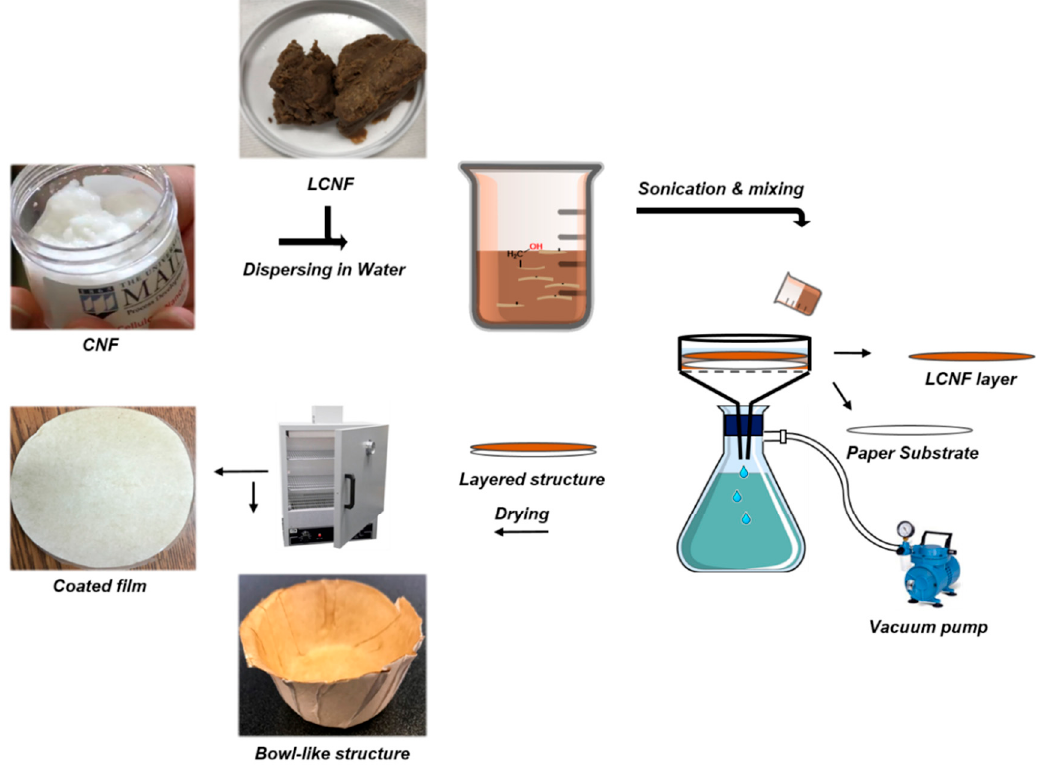
Figure 9. Schematic summary for fabrication process of films and oil resistant paper-based bowls via vacuum-assisted filtration coating and oven drying.